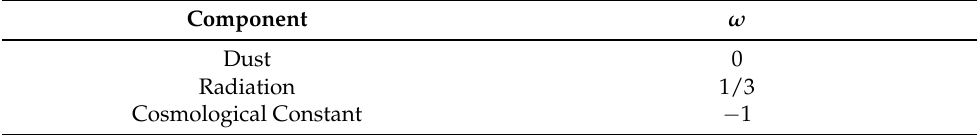
Table 4. Equation of state associated with each component of the